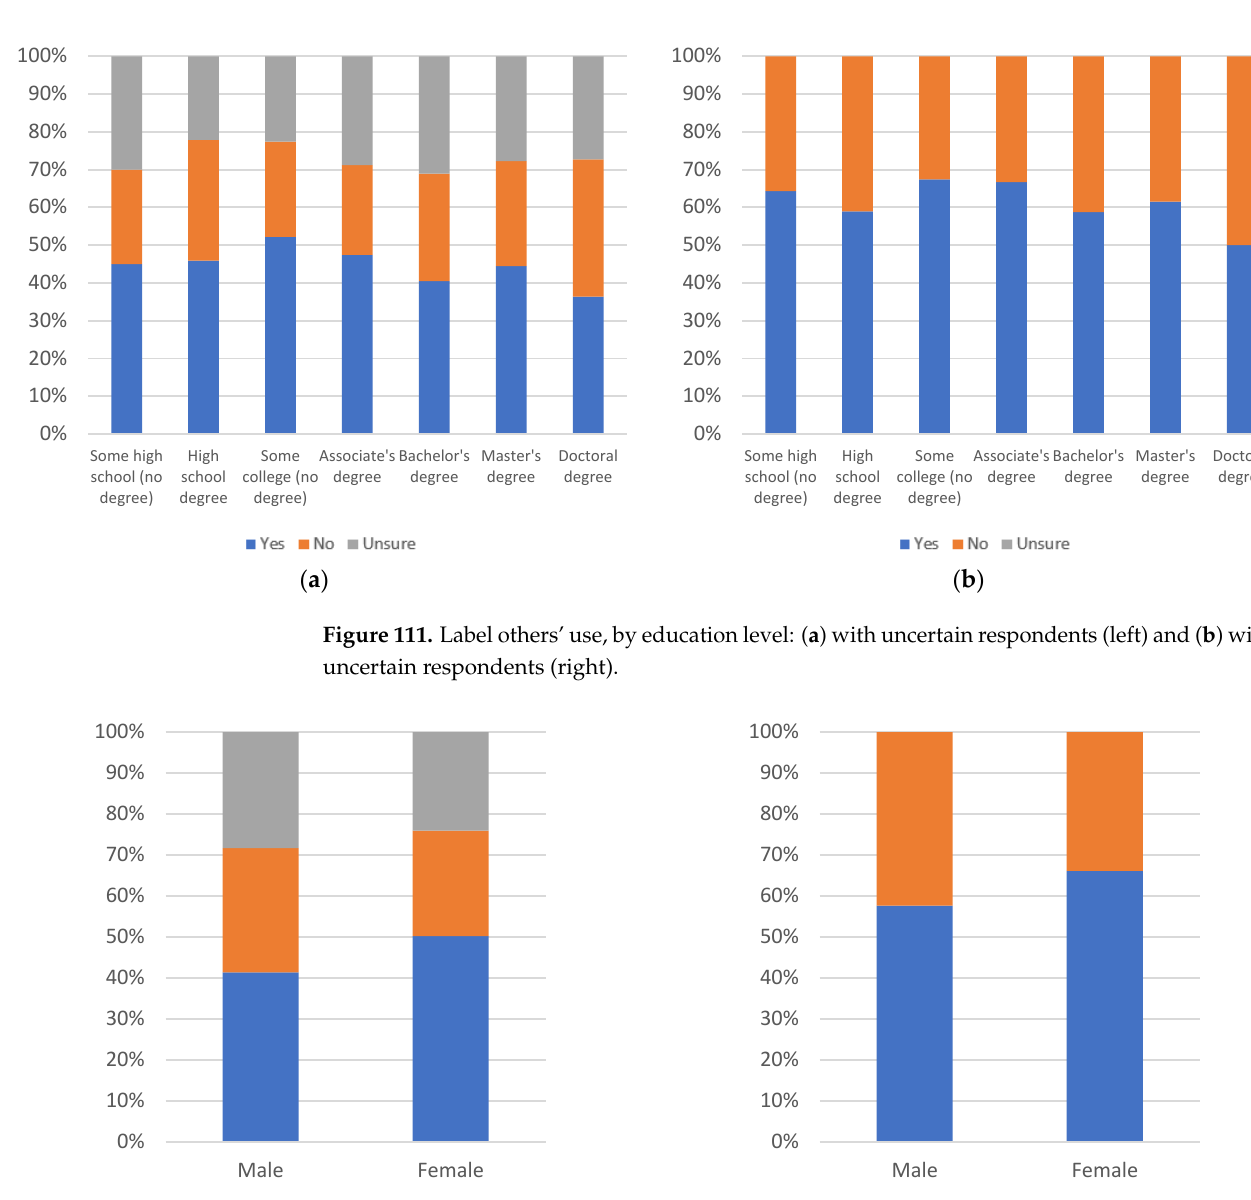
Figure 110. Label others’ use, by age group: ( a ) with uncertain respondents (left) and ( b ) without uncertain respondents (right).